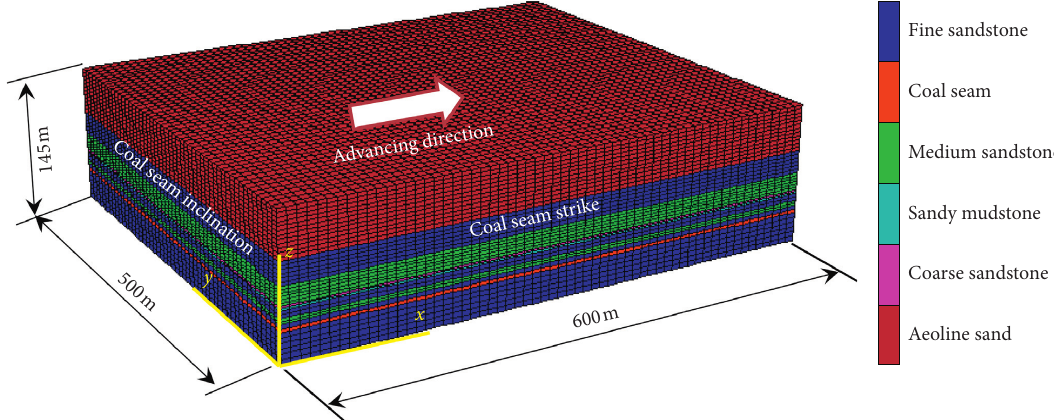
Figure 3: 3D numerical calculation model of mining.